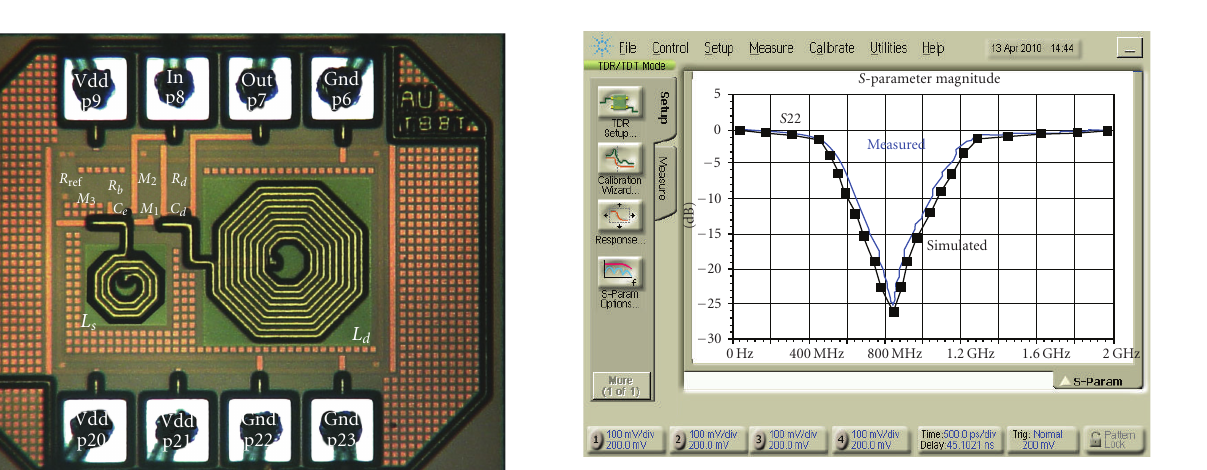
Figure 7: Output reflection coe ffi cient, S 22 (in dB) of the RFID LNA.